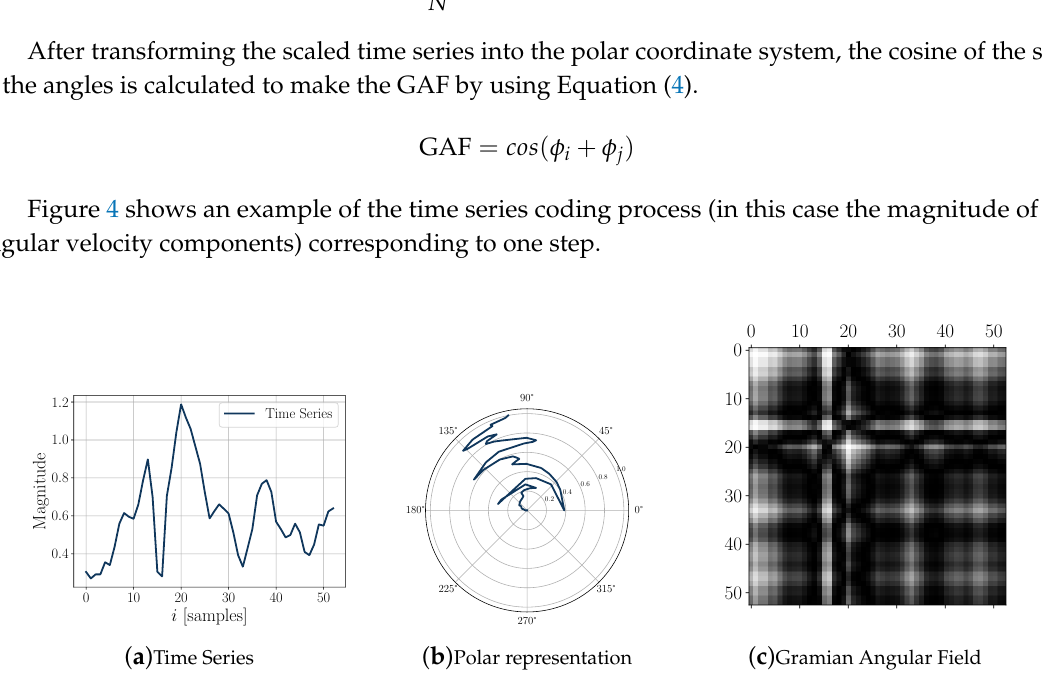
Figure 4. Encoding time-series process: ( a ) angular velocity magnitude time series; ( b ) polar representation; ( c ) GAF